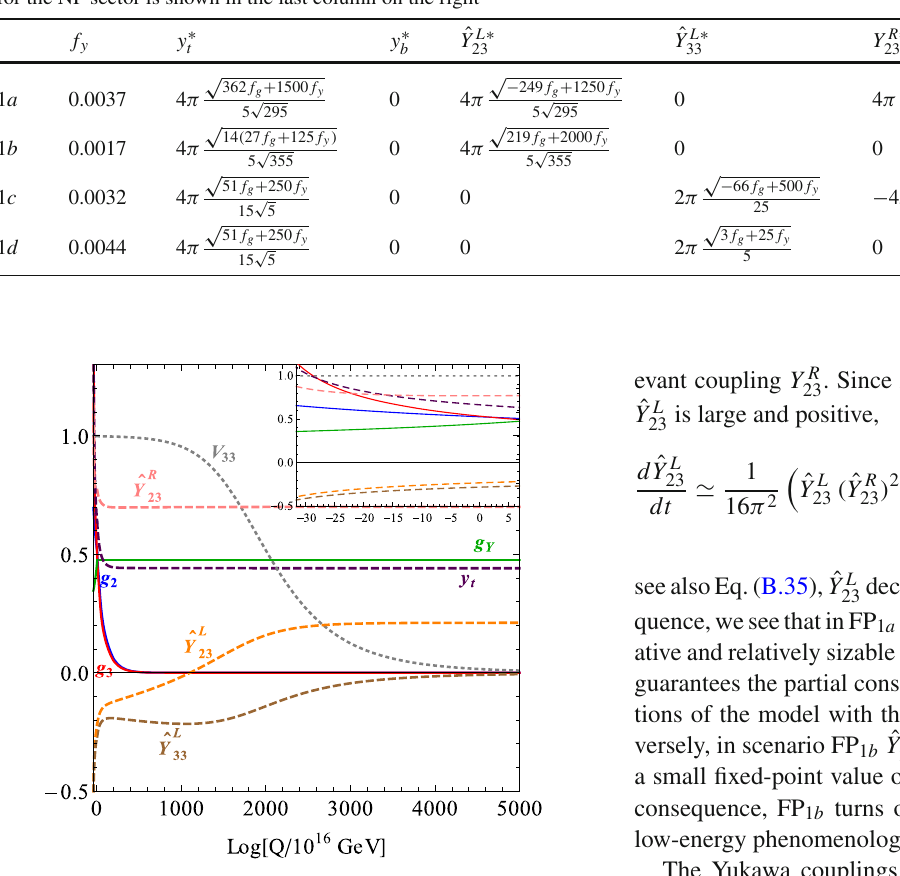
Fig. 5 RG flow of the gauge and Yukawa couplings from the trans- Planckian energies down to the EWSB scale in the case of scenario FP 1 a . The sub-Planckian flow is depicted in the inset panels